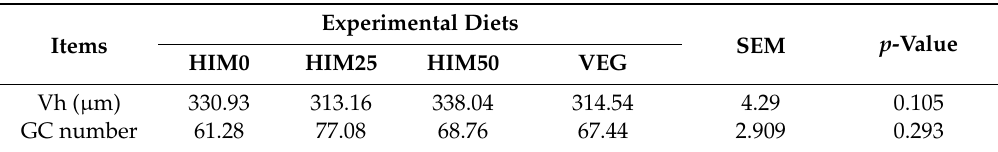
Figure 1. Histological and histochemical findings of Siberian sturgeon in the current trial. ( A ) Liver, Haematoxylin & Eosin stain, 10 × magnification. HIM0 diet. Occasional, multifocal vacuolization of the hepatocytes. ( B ) Liver, Haematoxylin & Eosin stain, 10 × magnification. Severe and di ff use vacuolization of the hepatocytes. VEG diet. ( C ) Spiral valve, 10 × magnification. Numerous goblet cells strongly reacting to periodic acid-Schi ff (PAS) stain are evident along the spiral valve epithelium. HIM25 diet. ( D ) Spiral valve, 10 × magnification. Several PAS-positive goblet cells are identified in the spiral valve villi. VEG diet. Abbreviations: H, Hermetia illucens larva meal; VEG, vegetable protein based diet. E ff ects of dietary H. illucens larva meal inclusion on gut morphology and neutral mucin-producing goblet cells of the sturgeons ( n =